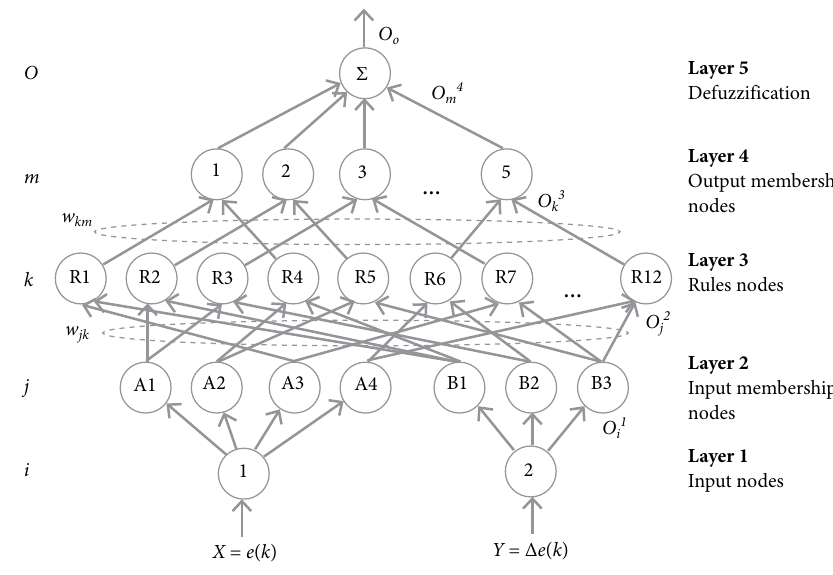
Fig. 3. Architecture of the neural-fuzzy controller by (Rubaai et al. 2005) for DC motor speed control of wheelchair type